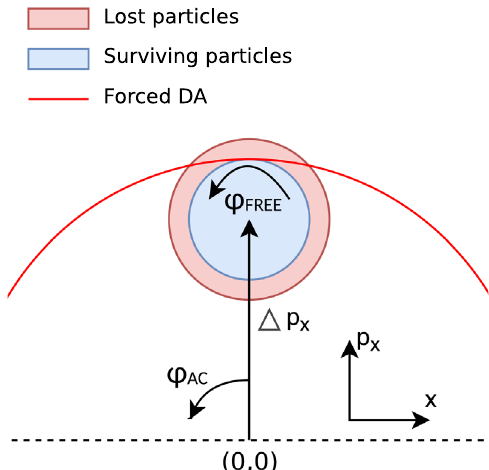
FIG. 9. Diagram showing where the losses in the particle bunch occur as a result of reaching the forced dynamic aperture. The remaining free motion inside the bunch will cause the tails of the bunch to be